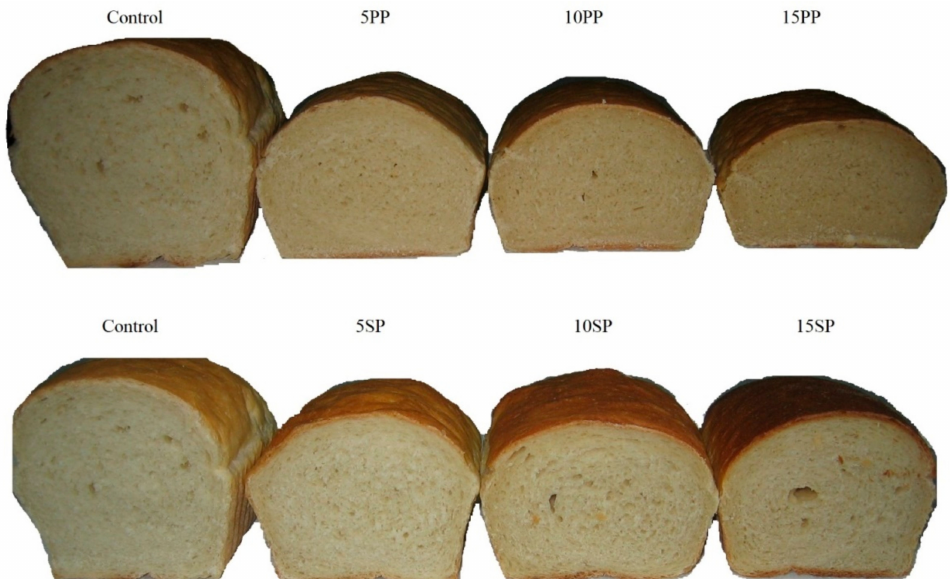
Figure 1. Comparation between bread obtained with different additions of pea protein concentrate (5PP, 10PP, and 15PP) and soy protein concentrate (5SP, 10SP, and 15SP), respectively, with the control bread. Table 4. Physical parameters of the bread samples.